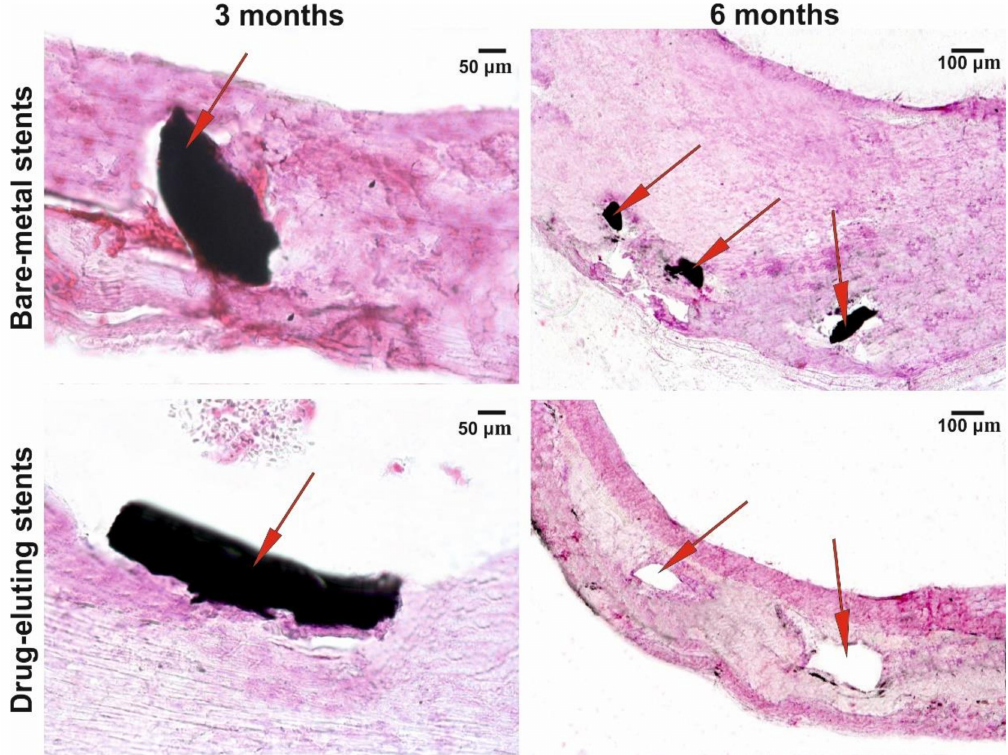
Figure 6. Microscopy of the cross sections of implants at di ff erent observation points. Staining with hematoxylin and eosin; AxioLab A1 with the Zen 2 Blue Edition software package (Carl Zeiss, Oberkochen, Germany); magnifications, × 100 and × 400; arrows denote stent’s struts or the sites where the struts are